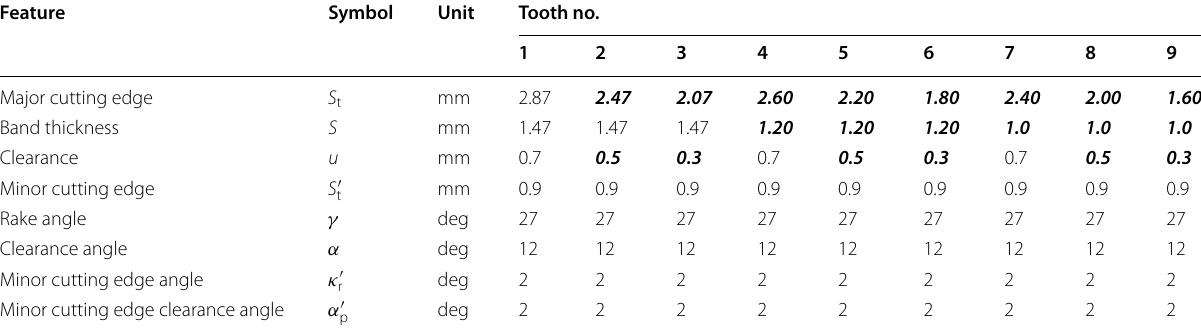
Bold-italic values indicate changed parameter values